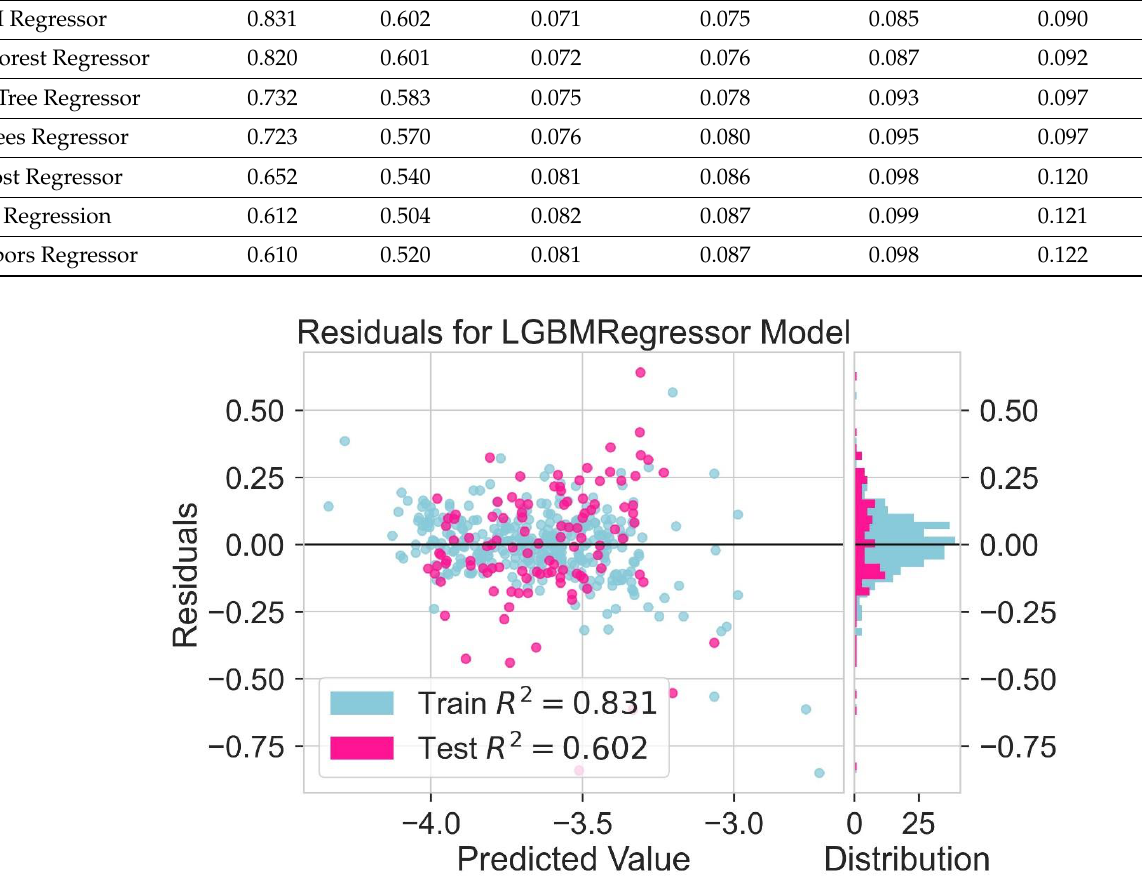
Figure 13. Residual for LGBM regression model for LUMO prediction.